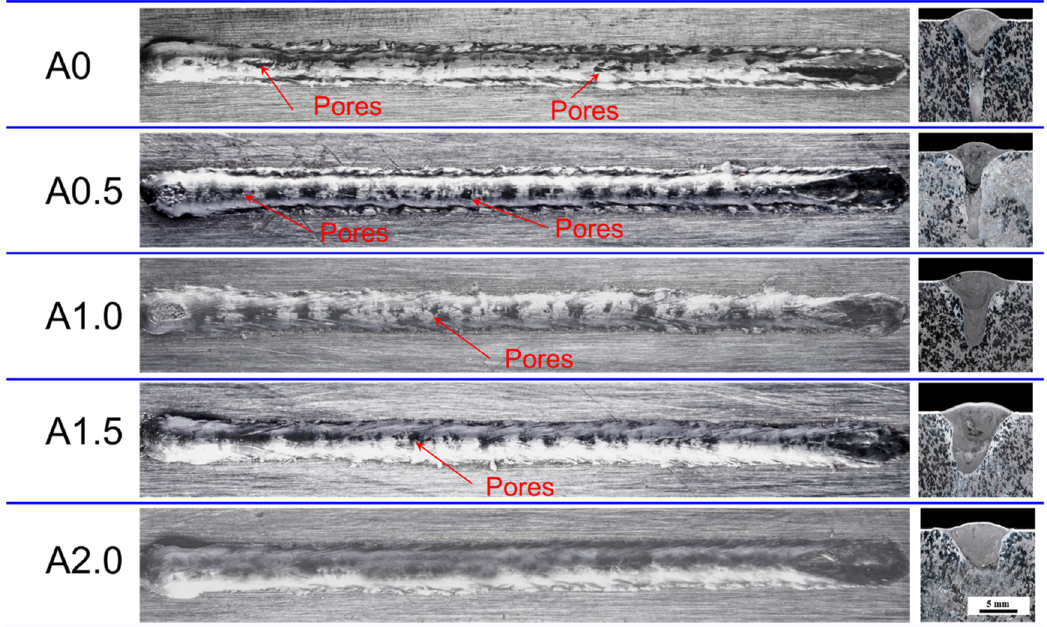
Figure 2. Typical macroscopic morphologies of the weld seam appearance and profile of 5356 Al alloy cladded on AZ80A by LAHW with different oscillating amplitudes.